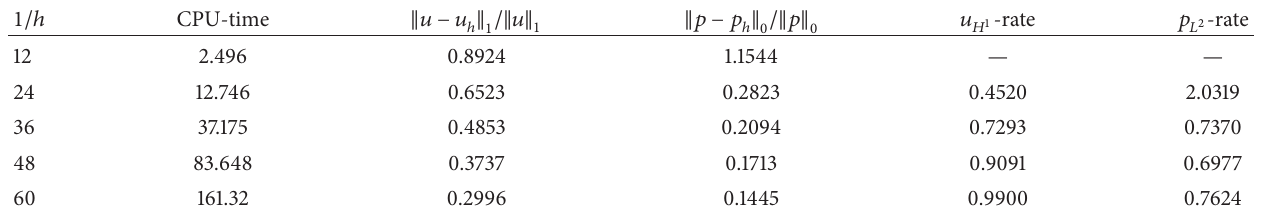
Table 3: Results got from the multiscale enrichment method with ] = 1.0𝑒 − 4 , 𝛼 = 1.0𝑒 − 4 , and 𝑟 = 3 .